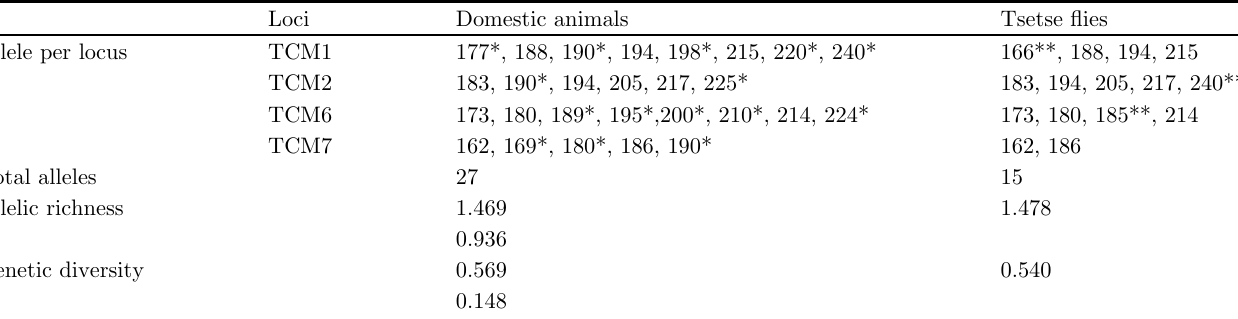
Table 3. Allelic richness and genetic diversity index for T. congolense “ forest type ” circulating in domestic animals and tsetse fl ies.